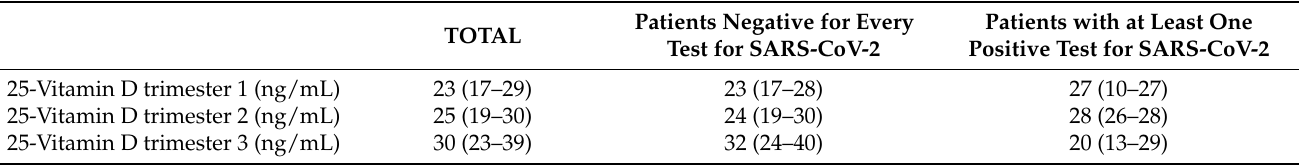
Table 3. Median 25-vitamin D levels (ng/mL) in preterm births (N = 11) compared to full-term pregnancy (N = 107). Patients Negative for Every Patients with at Least One TOTAL Test for SARS-CoV-2 Positive Test for